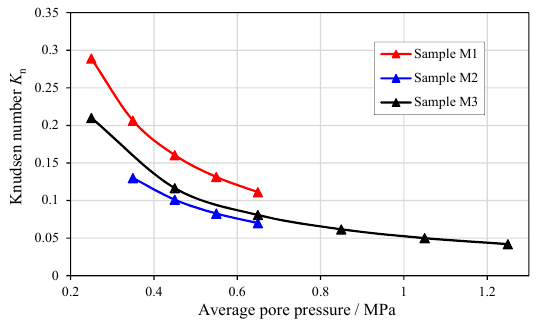
Figure 6. The Knudsen numbers at different average pore pressures.